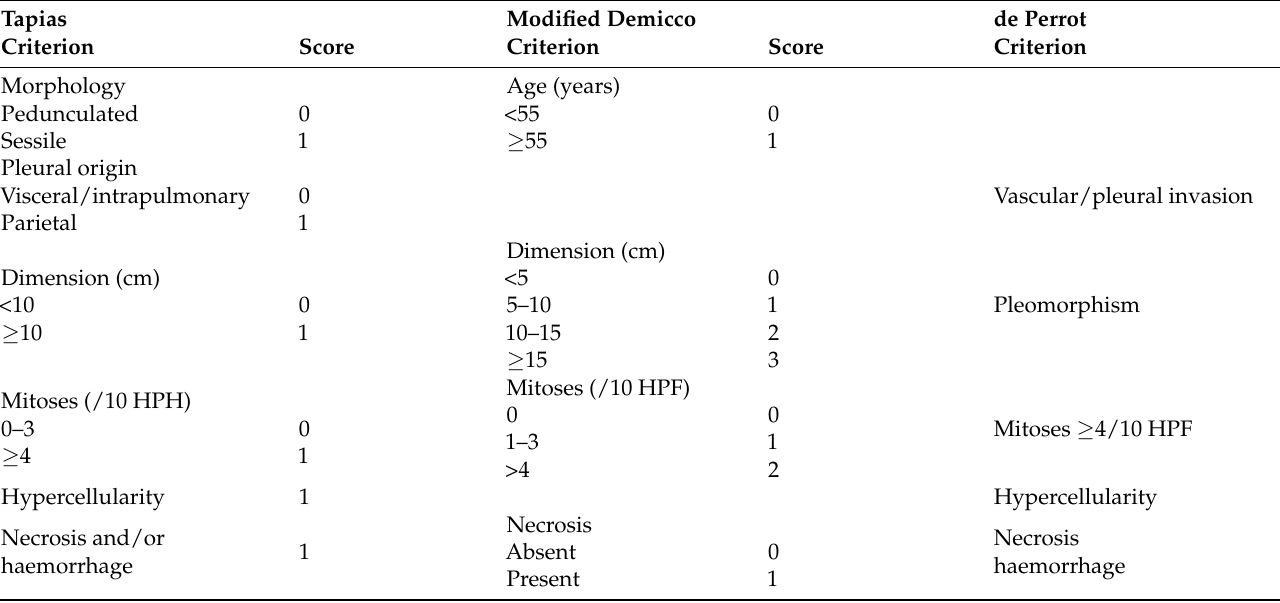
Table 1. Criteria and scoring systems of the three different stratification